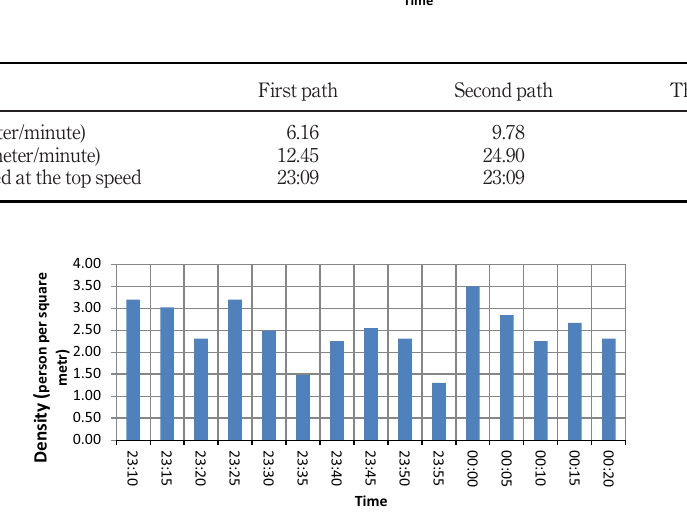
Figure 7. Speed of the visitors from tomb to Al-Baqi ’ Gate with time